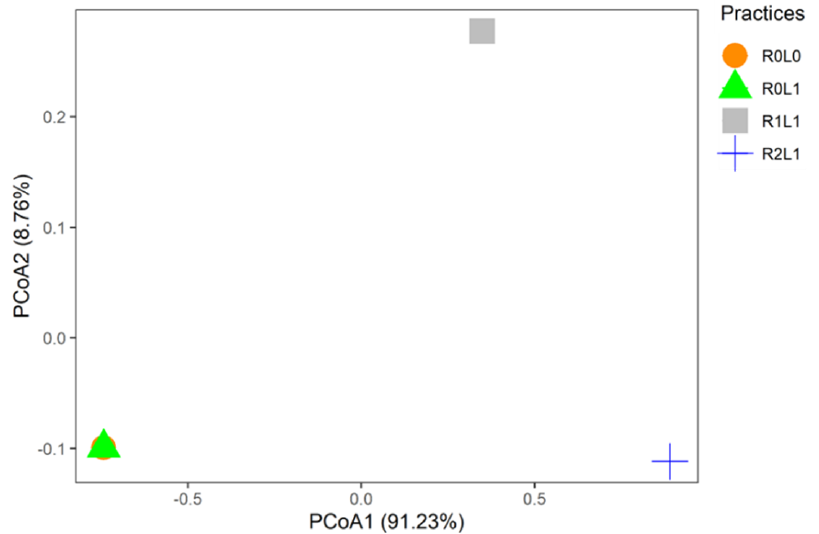
Figure 5. Principal coordinate analysis showing the patterns of functional composition of springtails communities in the different practices. This analysis is based on a Euclidean distance matrix. Points represent the centroid of replicates samples ( n = 3). R0L0–no residue or legume in the plot, R0L1—Legume ( Pueraria phaseoloides ) only, R1L1—Legume + stump + leaf + fine branches, R2L1—R1L1 + trunk.